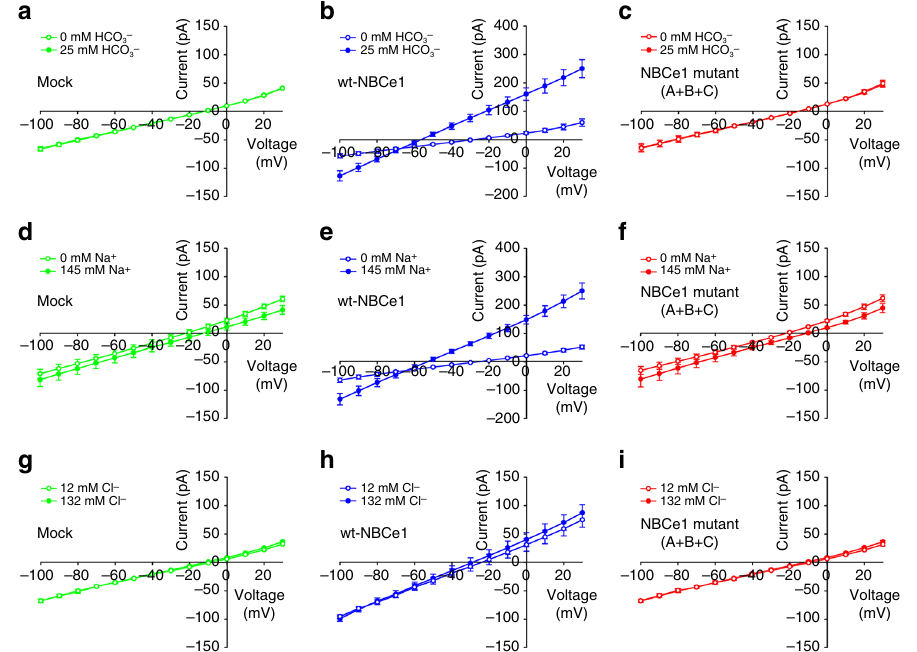
Fig. 5 Electrophysiological characterization of the NBCe1 483 SST-GFS/ 754 D-E/ 798 V-S/ 800 A-T/ 803 I-R mutant (A + B + C). The mutant 483 SST-GFS/ 754 D-E/ 798 V-S/ 800 A-T/ 803 I-R construct (NBCe1 Mutant A + B + C), which lost Na + -driven base transport and whose magnitude of Cl − -driven base transport approximated AE1, was studied electrophysiologically using whole-cell patch clamping. Unlike electrogenic wt-NBCe1 ( b , e , h ), the measured I – V curves of the mutant construct ( c , f , i ) under the various study conditions did not differ from those obtained in mock-transfected cells ( a , d , g ) demonstrating that the mode of transport of the mutant construct was